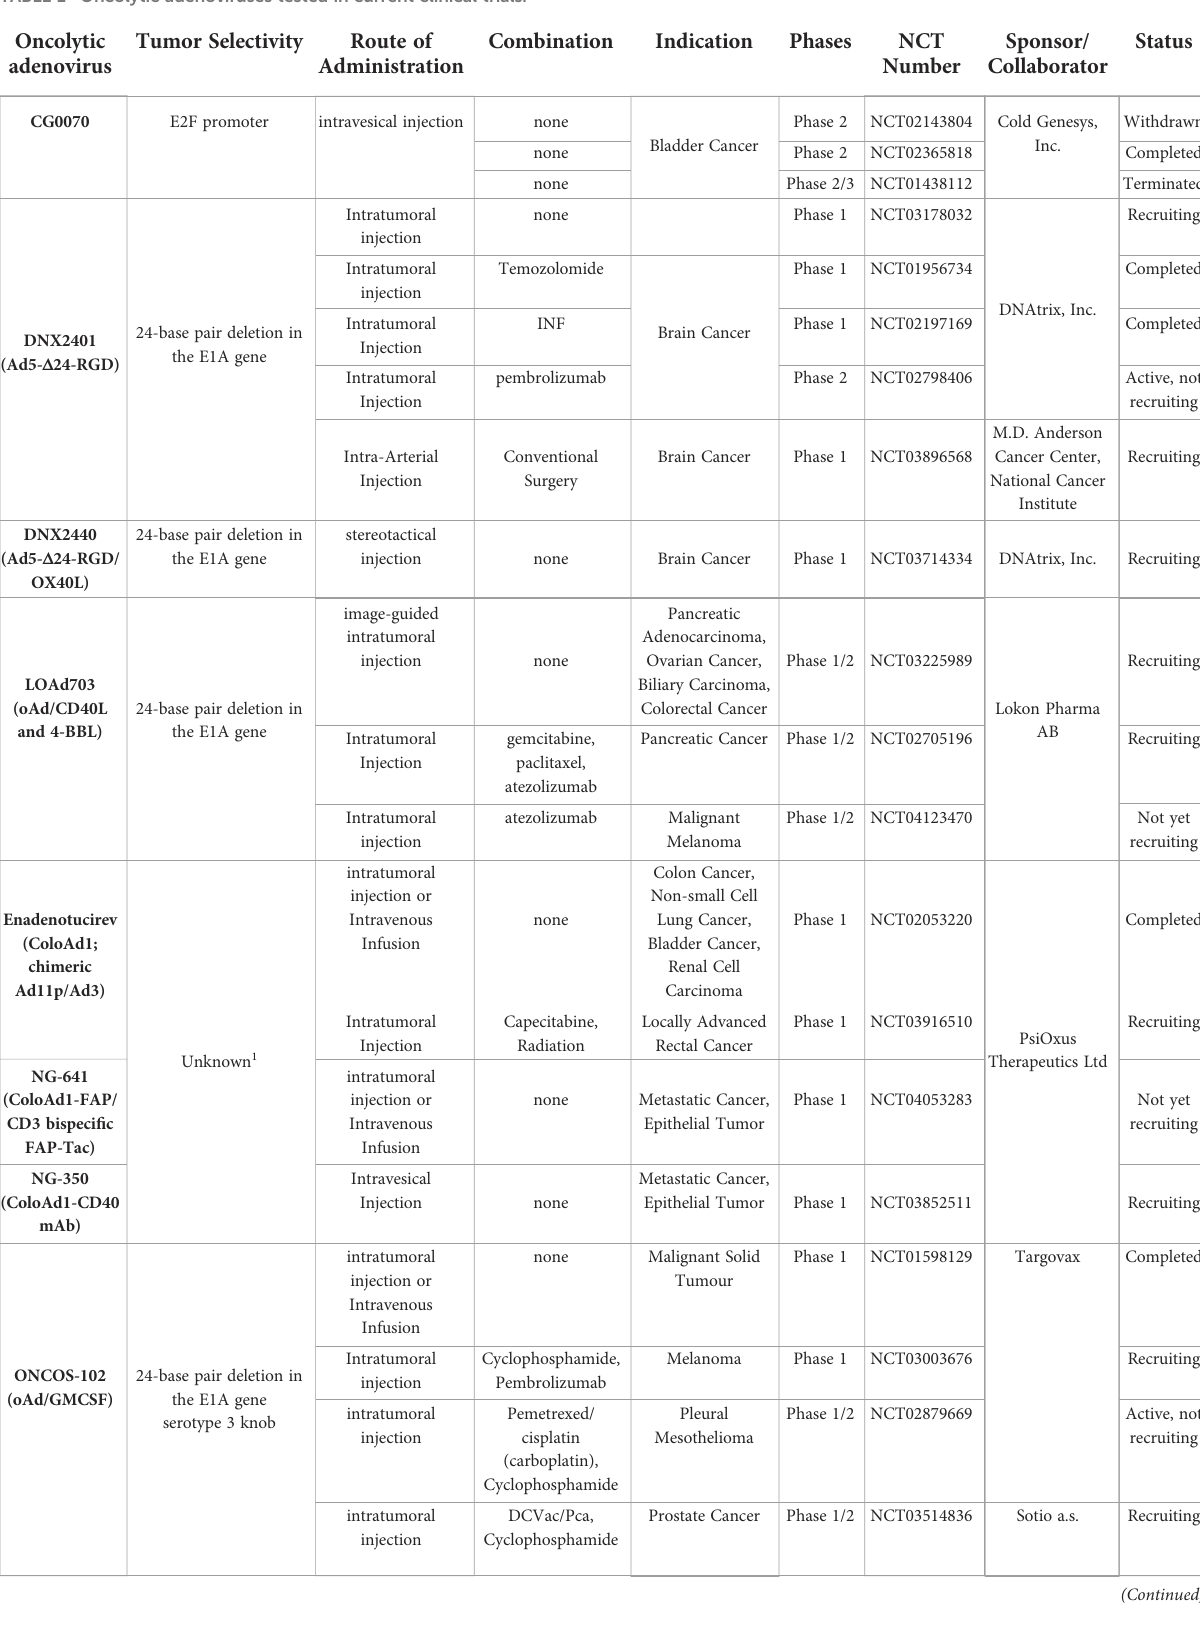
TABLE 1 Oncolytic adenoviruses tested in current clinical